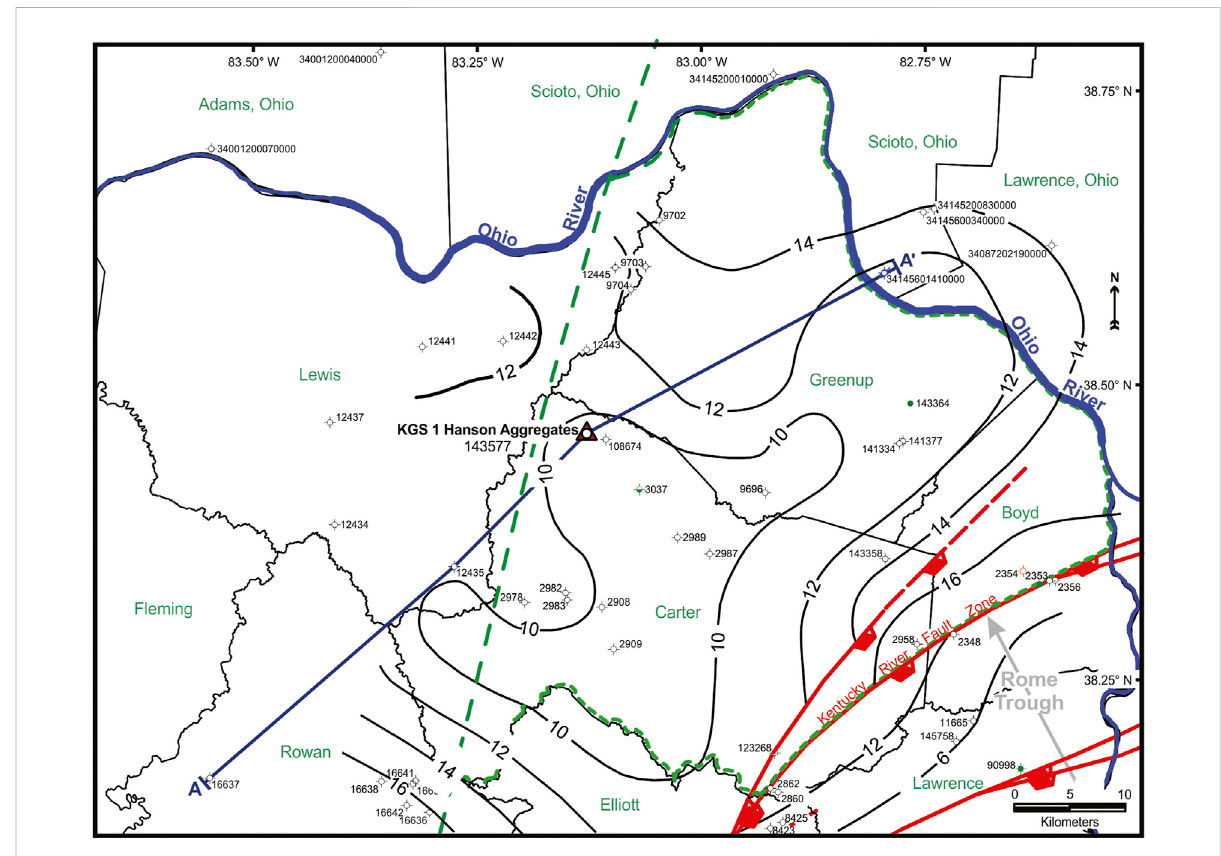
FIGURE 5 Isopach thickness of the Rose Run. In general, the Rose Run thickens and becomes more dolomitic to the southwest. Contour interval is 2